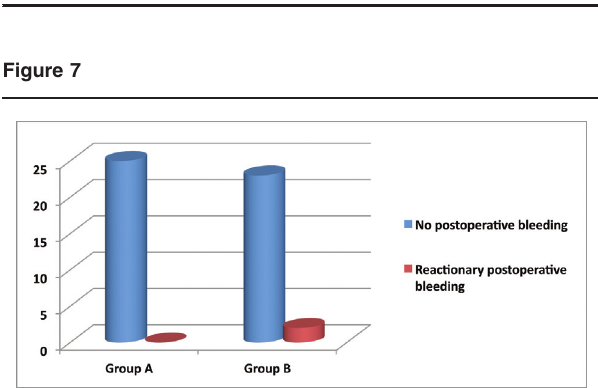
Rate of adenoid recurrence for both groups showed significant difference.